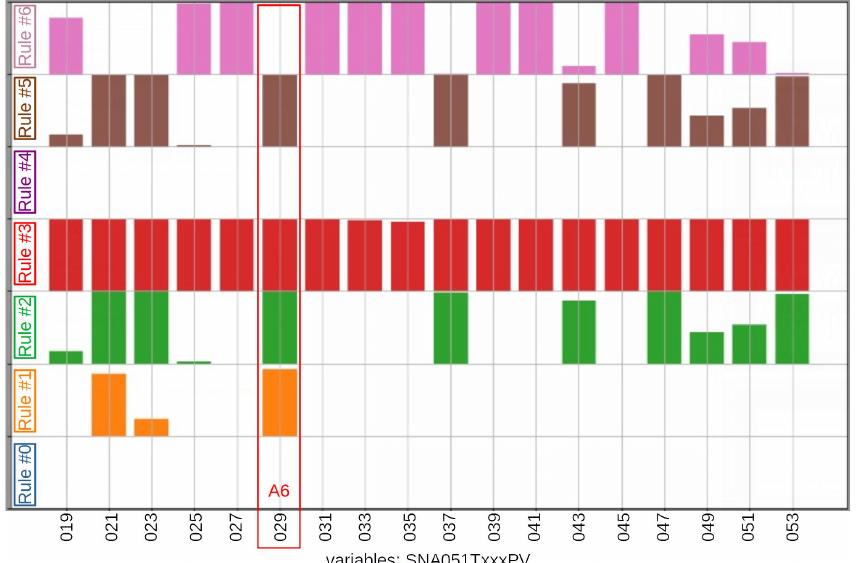
Figure 10. Bar graph of the exhaust gases subsystem during time window #1 (between 03:57 and 07:58).